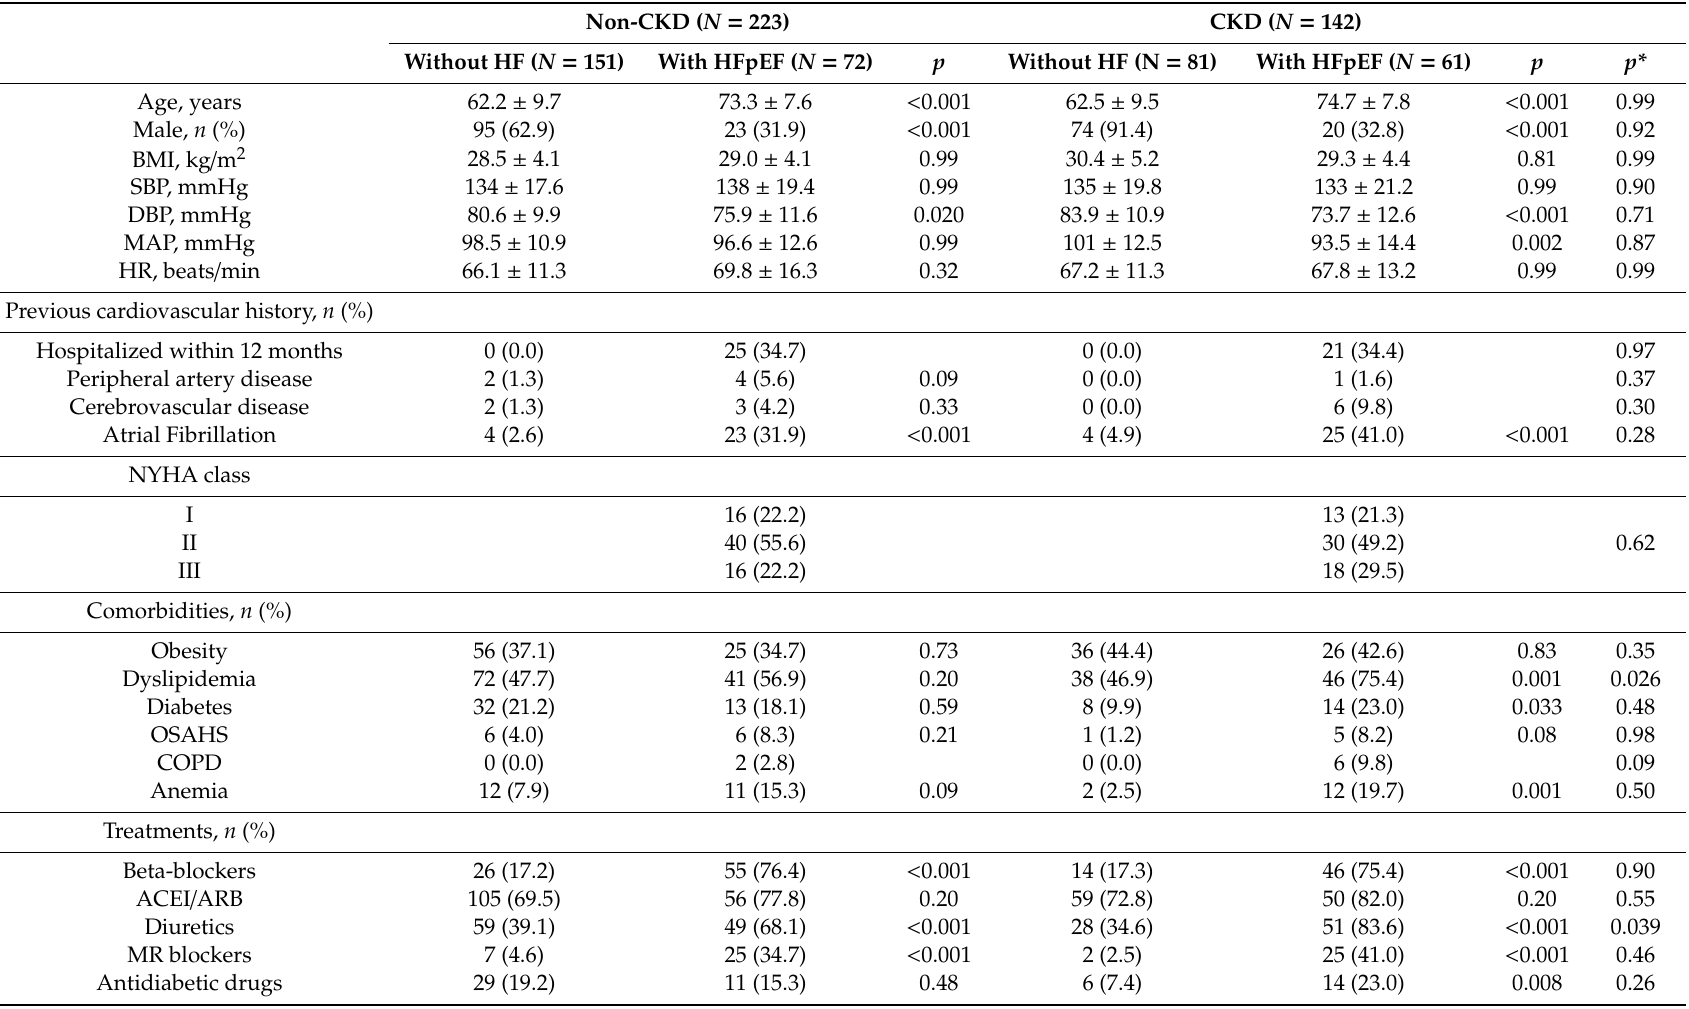
Table 3. Characteristics of patients classified according to presence or absence of CKD and with or without